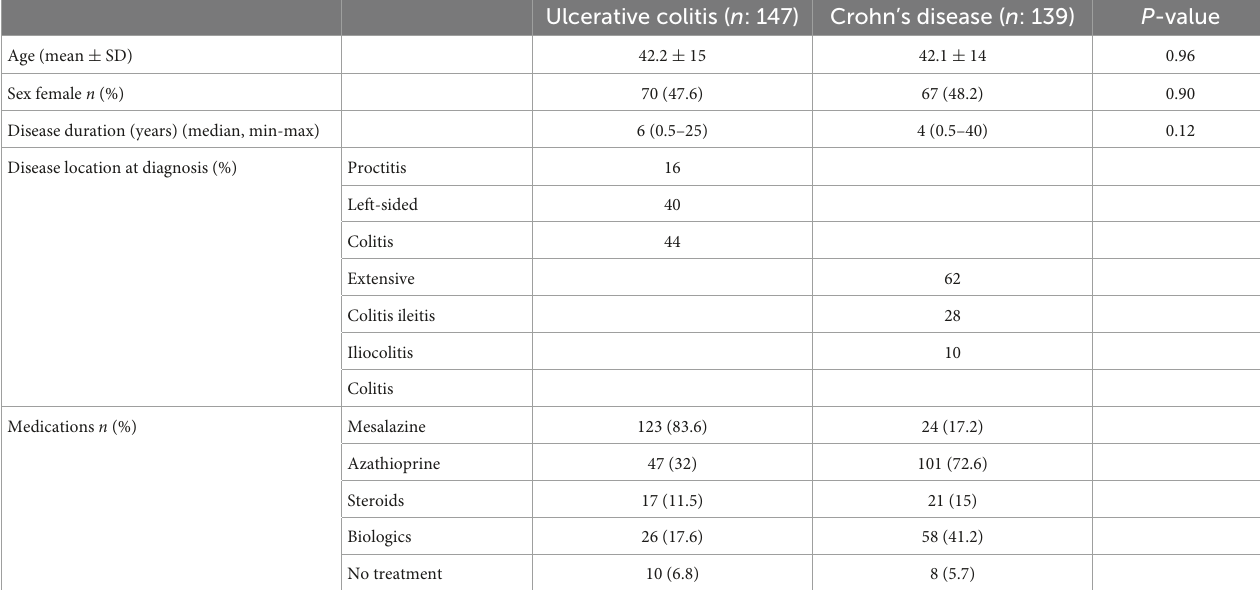
TABLE 1 Clinical characteristics of UC and CD